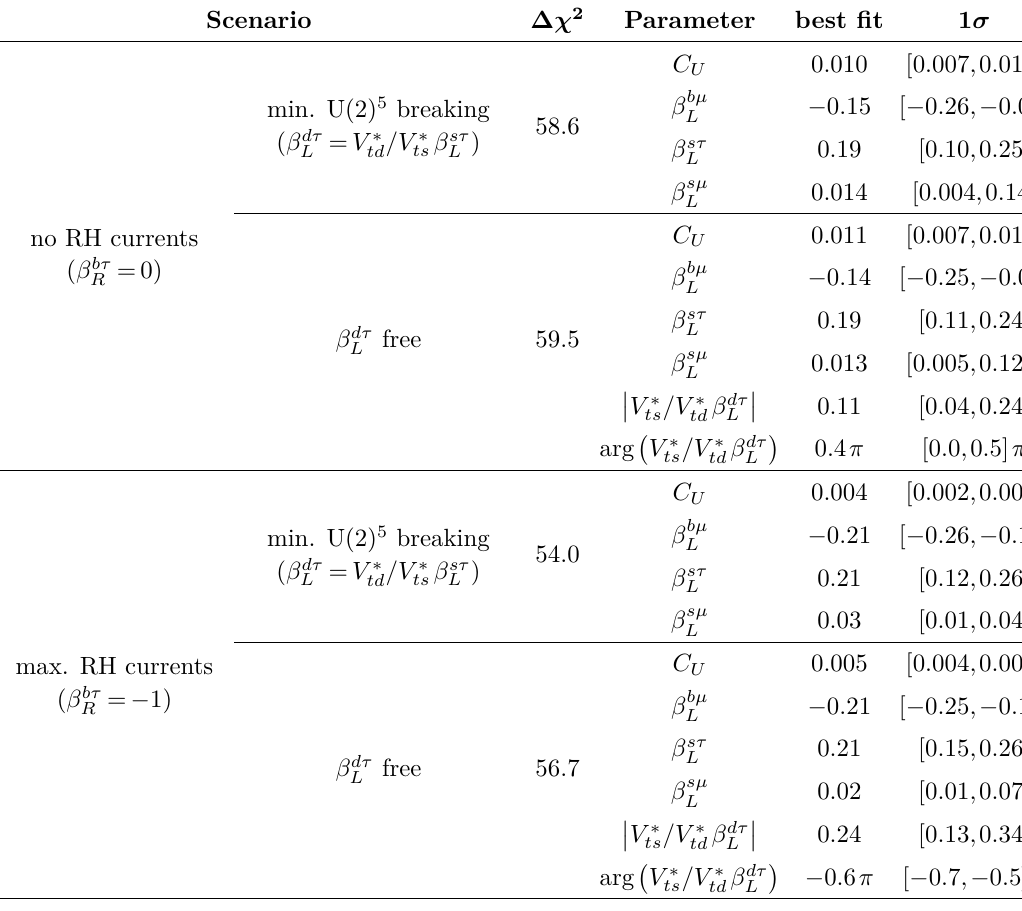
= 0 and β bτ = − 1 , with and without the additional assumption of Table 4 . Fit results for β bτ R R minimal U(2) 5 breaking. For each scenario we report the ∆ χ 2 = χ 2 − χ 2 , the best-fit values and SM the 1 σ confidence intervals (marginalizing over the other parameters) for all fit